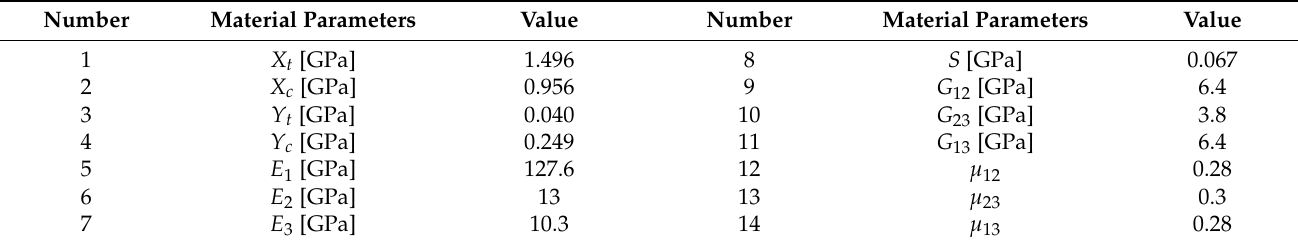
Table 3. Mechanical property parameters of CFRP T300/5208.